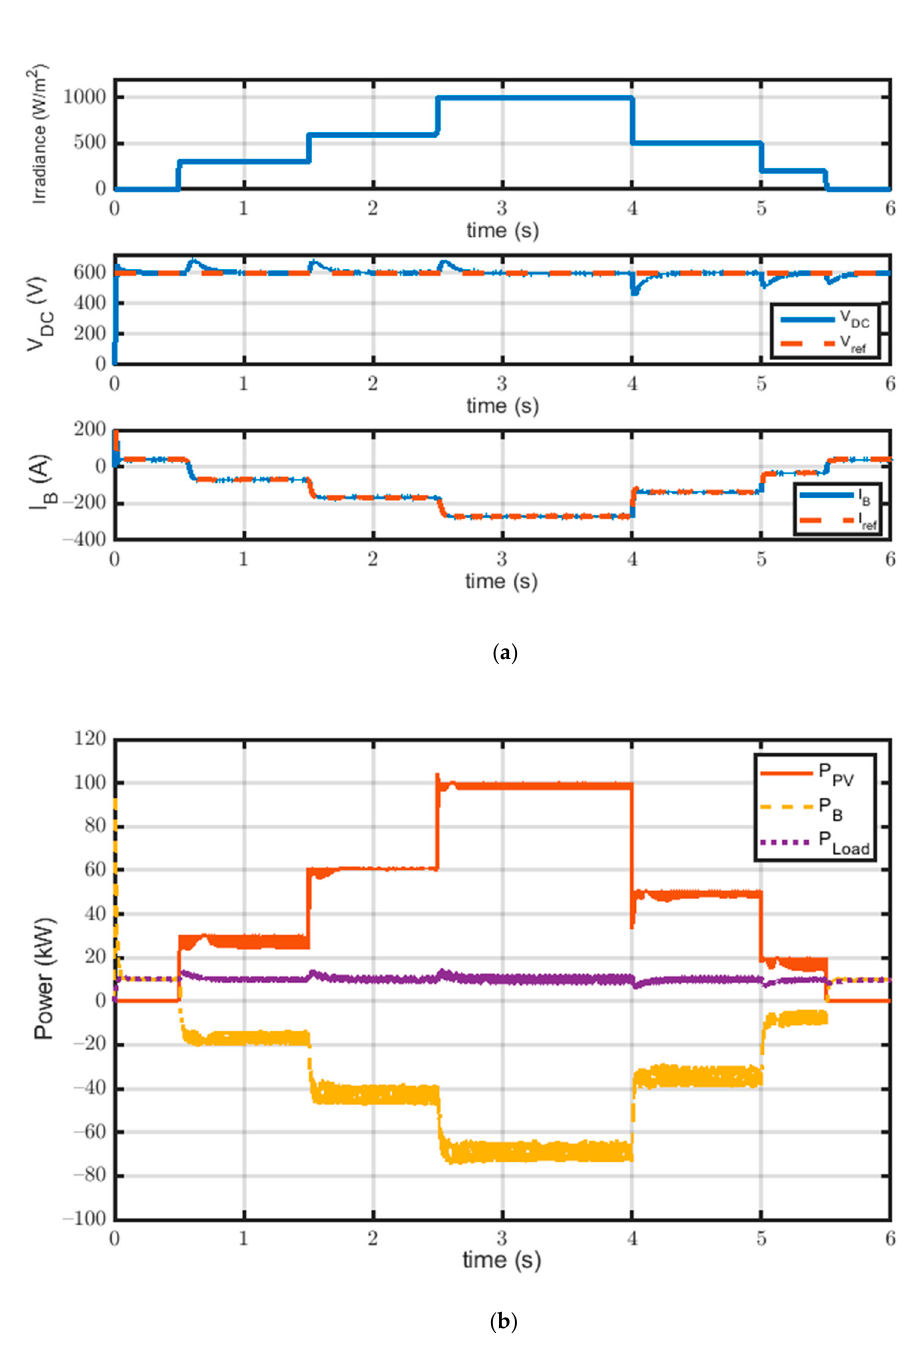
Figure 9. Islanded PV microgrid response; ( a ) Irradiation, DC voltage at load point and battery current, and ( b ) Power flow through DC microgrid.